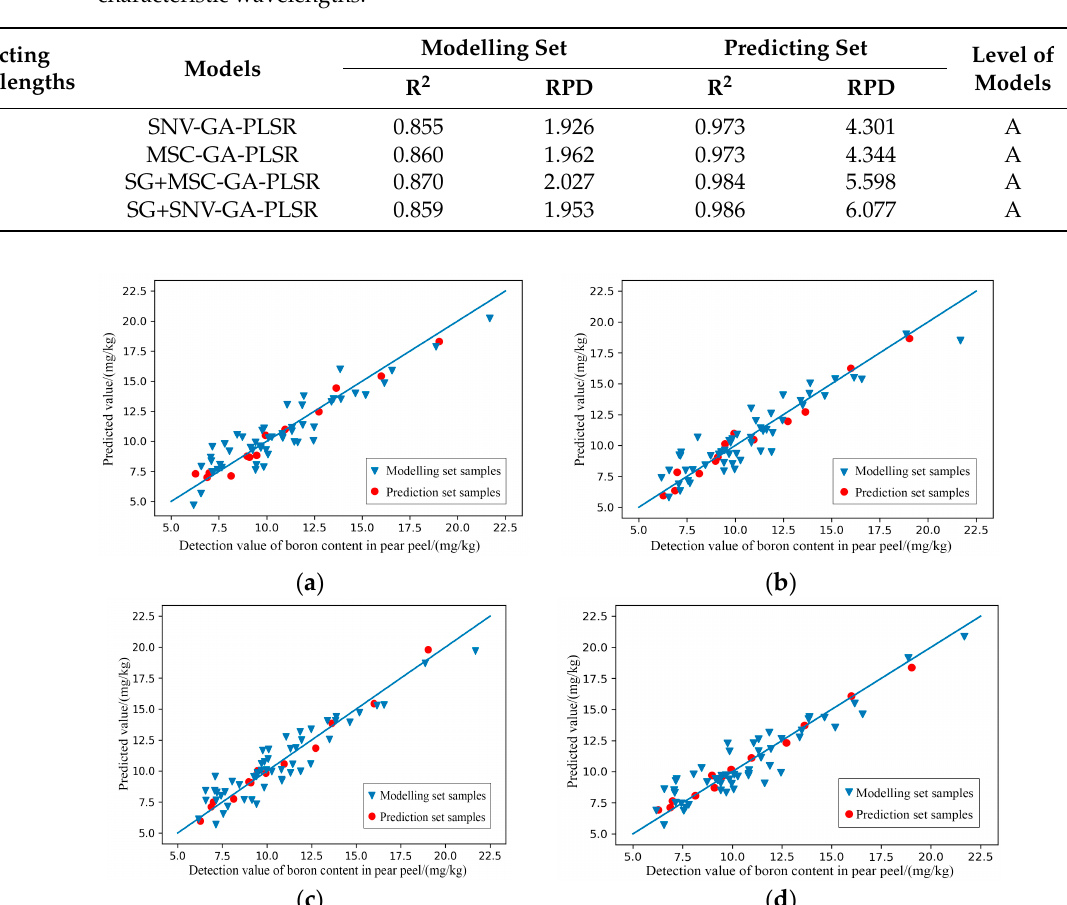
Table 8. Modelling prediction results of the content of boron in pear peel based on the selected characteristic wavelengths.